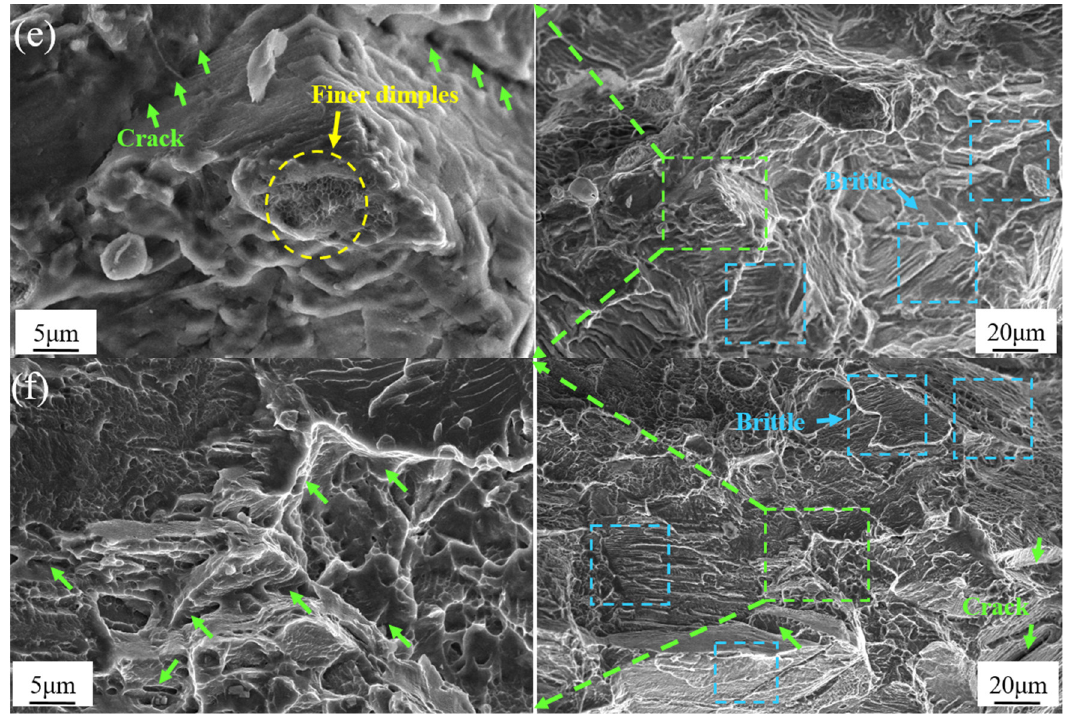
Figure 15. SEM images of tensile specimens in ( a ) WQ (20 °C), ( b ) WQ (100 °C), ( c ) AC, ( d ) WQ (20 °C) with aging, ( e ) WQ (100 °C) with aging and ( f ) AC with aging states.